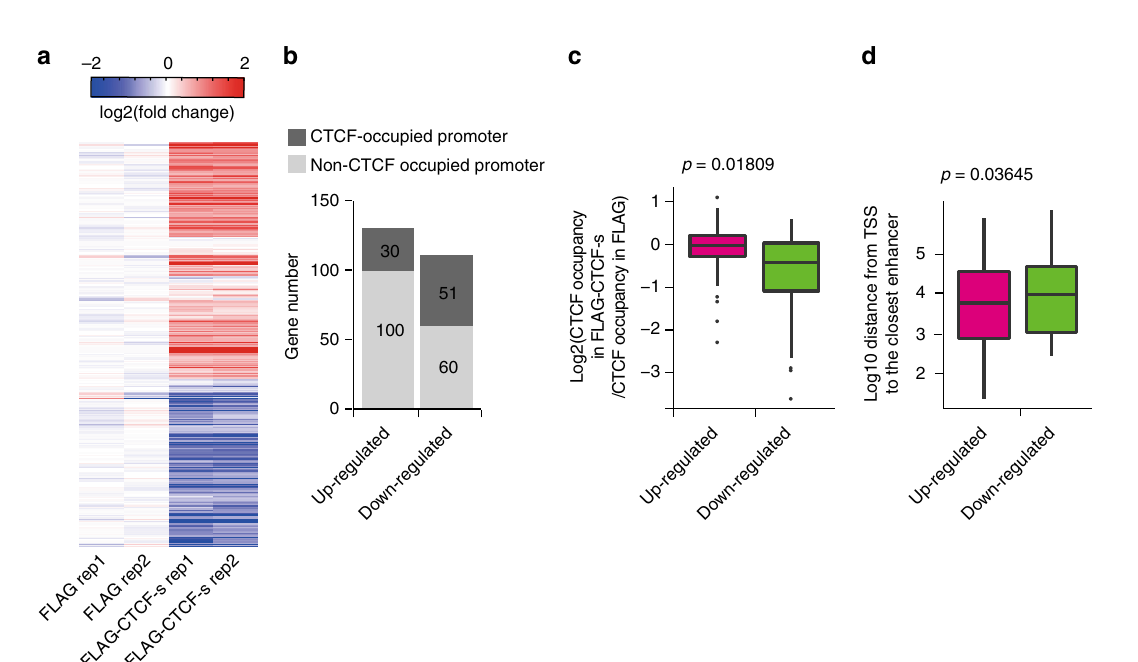
Fig. 3 CTCF-s competition causes the reduction of both CTCF and cohesin binding and alters CTCF-mediated chromatin looping. a Venn diagrams showing the overlap of RAD21 and CTCF peaks. b Venn diagrams showing the overlap of RAD21 binding sites with signi fi cantly decreased CTCF binding sites upon CTCF-s gain-of-function, from cluster 1 in Fig. 2f. c Heatmap and pileup for CTCF and RAD21 ChIP intensity in CTCF bound sites that decreased when FLAG-CTCF-s was overexpressed. d Raw interaction maps of CTCF HiChIP at a locus on chromosome 1 produced from FLAG control cells and cells with FLAG-CTCF-s overexpression and Hi-C data in HeLa-S3 cells drawn with the indicated resolutions and views. Numbers above the interaction maps correspond to maximum signal in the matrix. e Bar chart showing loop difference from HiChIP data in both FLAG control cells and cells with FLAG-CTCF-s overexpression. f Boxplot showing the distribution of loop intensities in average log2 counts per million (log2CPM) among the three loop classes (up, down and unchanged) from ( e ). The midline represents the second quartile, the bounds of box represent third quartile and fi rst quartile. The whiskers indicate 1.5 × interquartile range and dots represent outliers. g Features of downregulated loops with distinct anchor features in FLAG control from ( f ). The loop anchor features were classi fi ed from the change of CTCF binding strength in FLAG control and FLAG-CTCF-s overexpressed samples. The midline represents the second quartile, while the bounds of box represent third quartile and fi rst quartile, respectively. The whiskers indicate 1.5 × interquartile range and dots represent outliers. h Fold-change analysis of downregulated loops that were associated with distinct anchor features that were classi fi ed from FLAG control and FLAG-CTCF-s overexpressed samples after FLAG-CTCF-s gain-of-function. The midline represents the second quartile, the bounds of box represent third quartile and fi rst quartile. The whiskers indicate 1.5 × interquartile range and dots represent outliers. i Example genomic view showing the changes of CTCF ChIP intensities and CTCF-mediated chromatin loops at the MDM2/CPM gene locus. The directionality of the motifs at CTCF loop anchors was indicated with red arrows